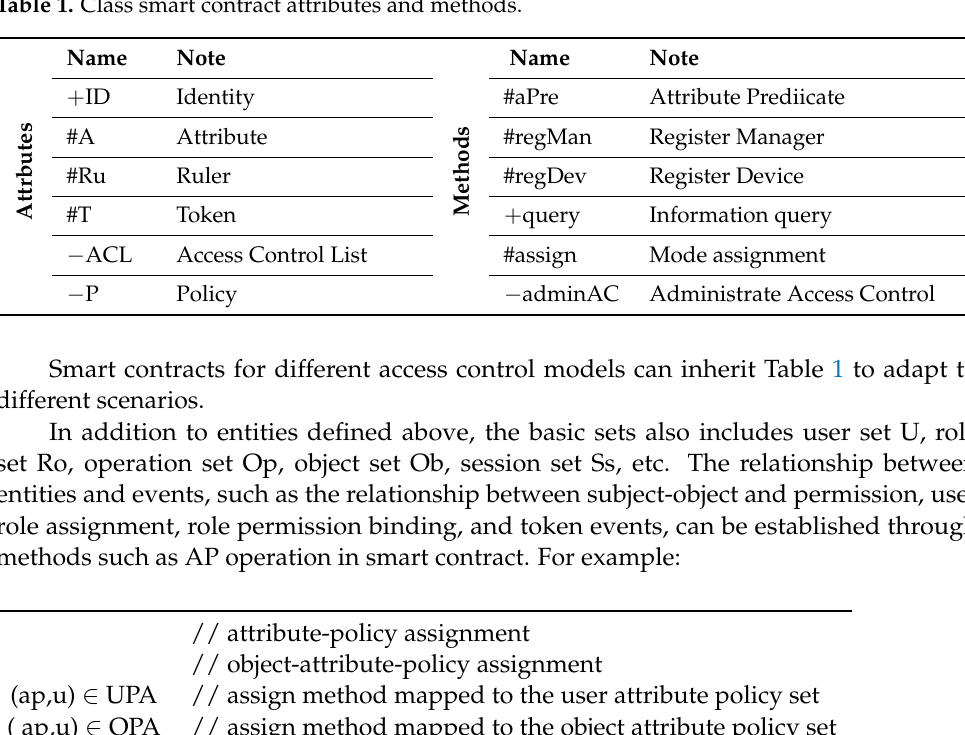
Table 1. Class smart contract attributes and